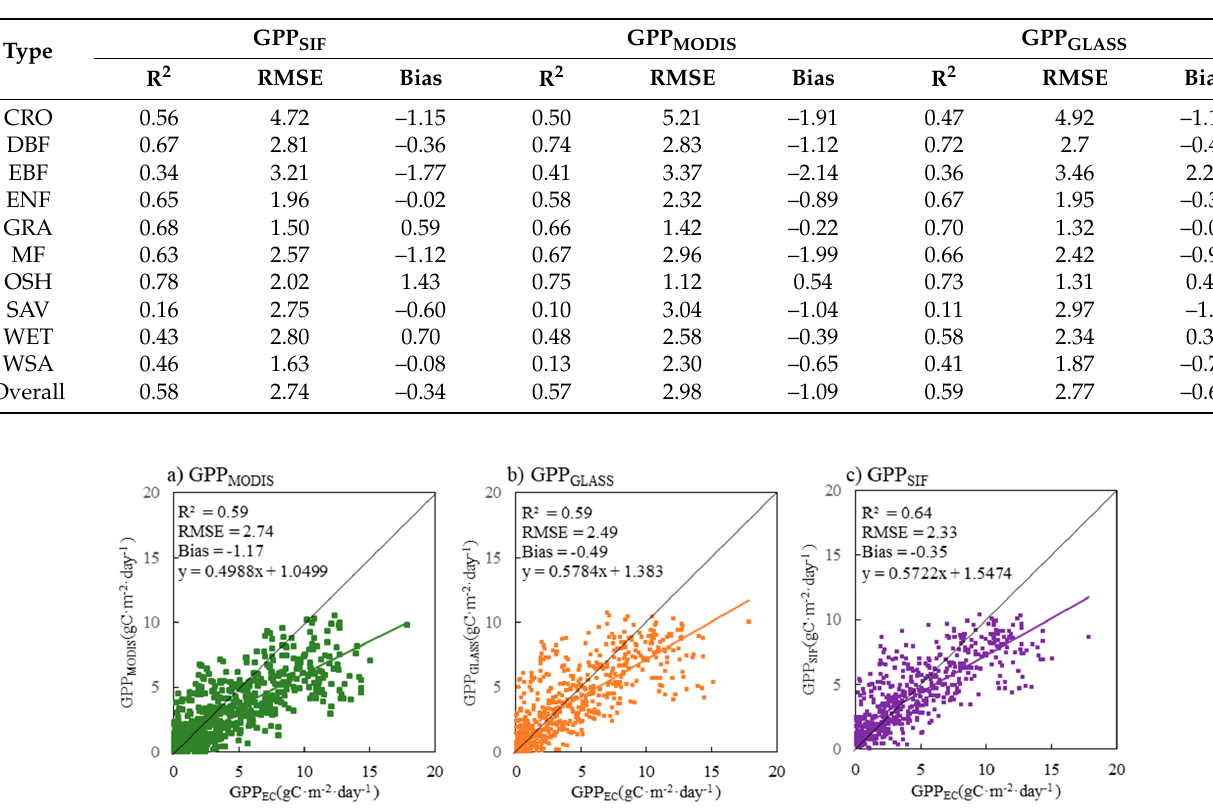
Table 1. Comparisons of R 2 , RMSE, and bias between GPP SIF , GPP MODIS , GPP GLASS , and GPP EC for different vegetation types for the period 2001 to 2014. CRO: croplands, DBF: deciduous broadleaf forests, EBF: evergreen broadleaf forests, ENF: evergreen needleleaf forests, GRA: grasslands, MF: mixed forests, OSH: open shrublands, SAV: savannas, WET: wetland, and WSA: woody savannas.